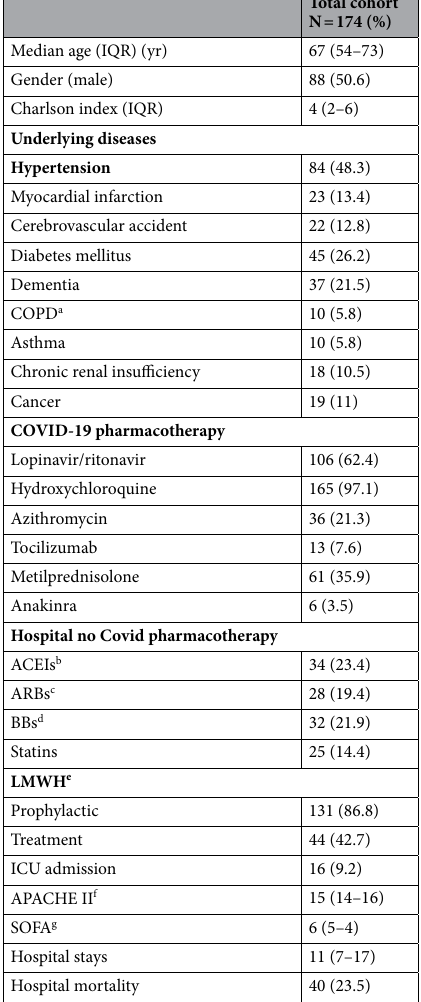
Table 1. Primary diagnoses, underlying diseases, and clinical characteristics of the patients. a COPD denotes Chronic obstructive pulmonary disease. b Angiotensin-converting enzyme inhibitors. c Angiotensin receptor blockers. d Beta blockers. e Low-molecular-weight heparin. f APACHE II denotes Acute Physiology and Chronic Health Evaluation score. g SOFA denotes Sequential Organ Failure